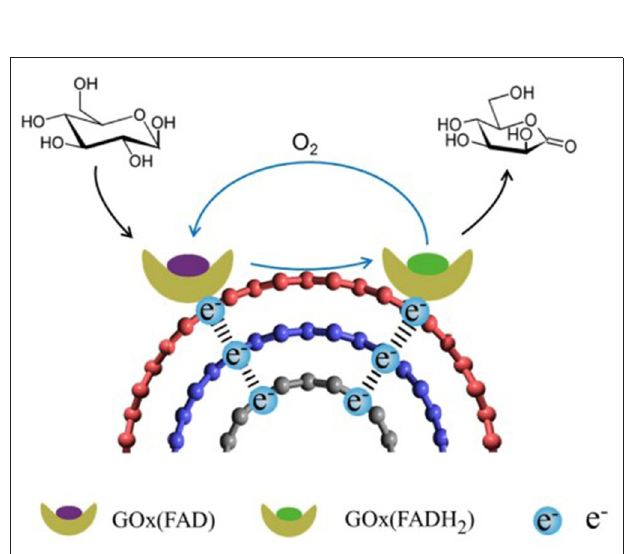
FIGURE 3 | Schematic of proposed route of DET for GOx physisorbed with multi-walled carbon nanotubes (Liu et al., 2018) (https://pubs.acs.org/doi/full/ 10.1021/acsomega.7b01633. Further permissions related to the material should be directed to